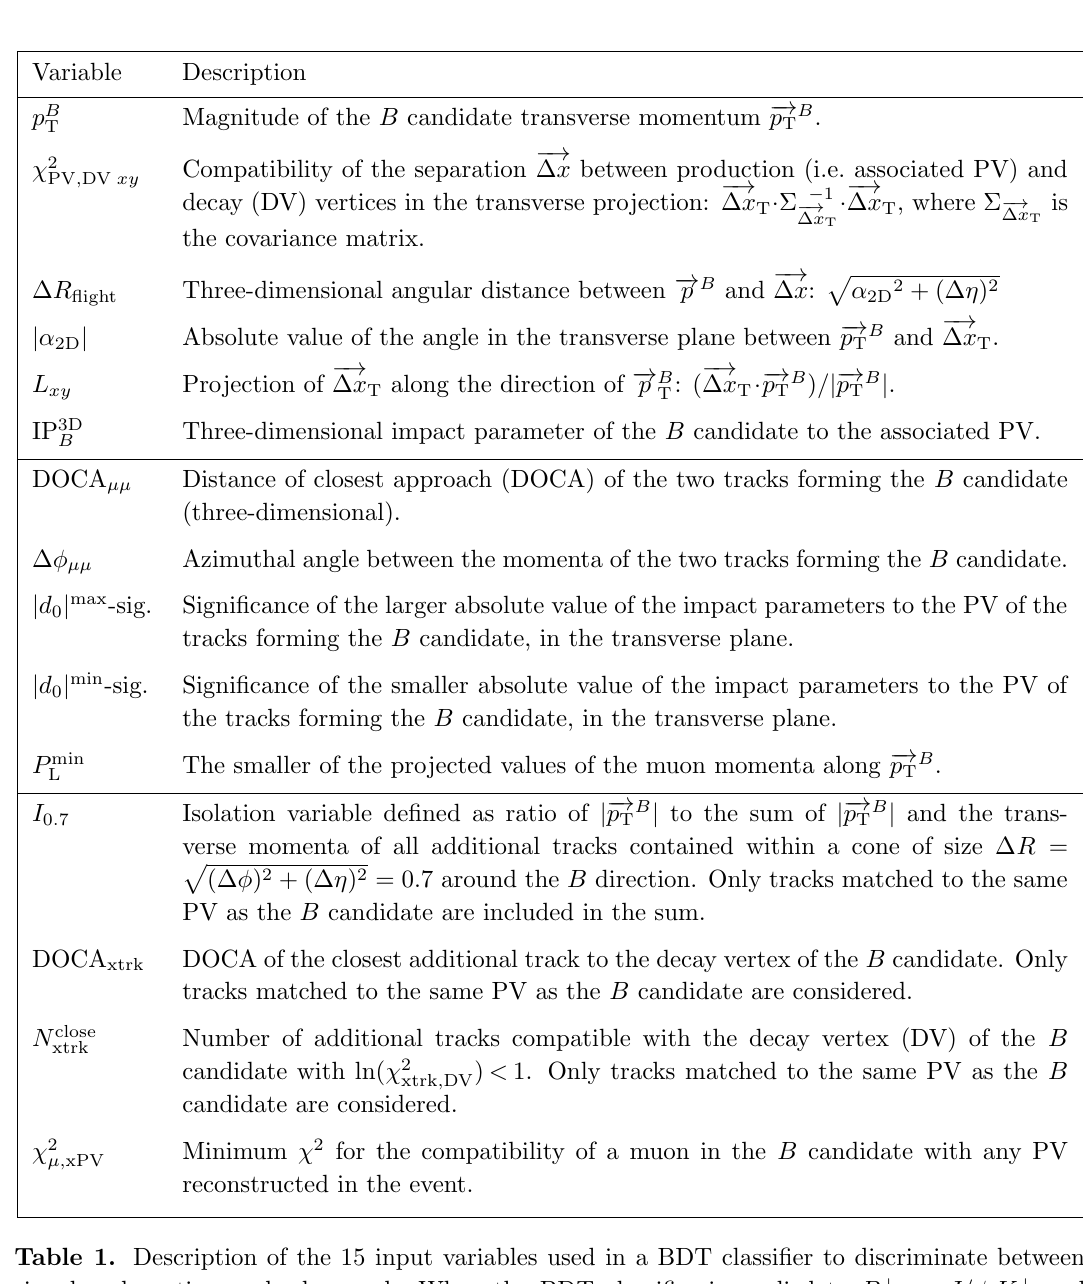
Table 1. Description of the 15 input variables used in a BDT classi(cid:12)er to discriminate between signal and continuum background. When the BDT classi(cid:12)er is applied to B + ! J= K + and B 0 ! J= (cid:30) candidates, the variables related to the decay products of the B mesons refer only to s the muons from the decay of the J= . Horizontal lines separate the classi(cid:12)cations into groups (a), (b) and (c) respectively, as described in the text. For category (c), additional tracks are required to have p T > 500